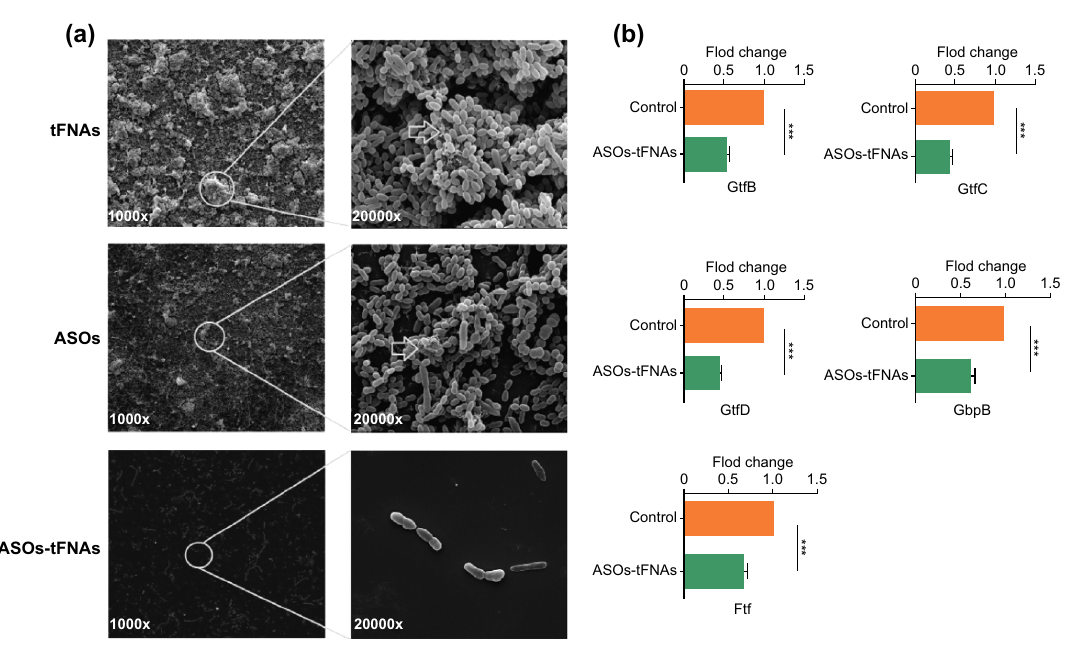
Fig. 5 Cellular and molecular mechanisms responsible for inhibiting biofilm formation upon ASOs-tFNAs targeting. a Representative SEM images showing the architecture of biofilms following 24 h of incubation with tFNAs, ASOs, or ASOs-tFNAs. Images were taken at × 1000 and × 20,000 magnification, b expression of target genes as determined by quantitative RT-PCR. 16S rRNA was used as control. *** P < 0.001